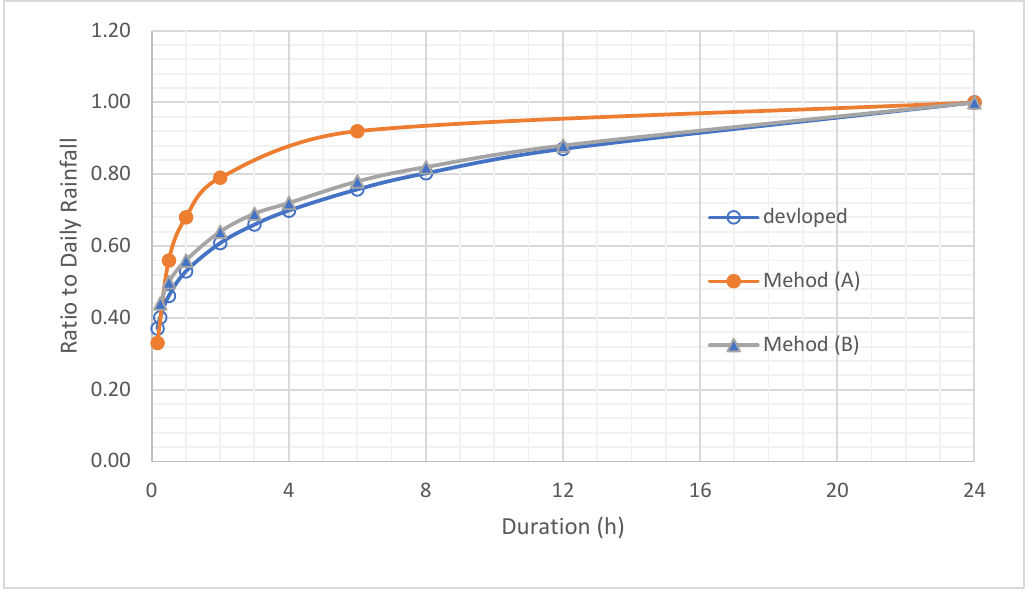
Figure 10. Ratio to daily rainfall.